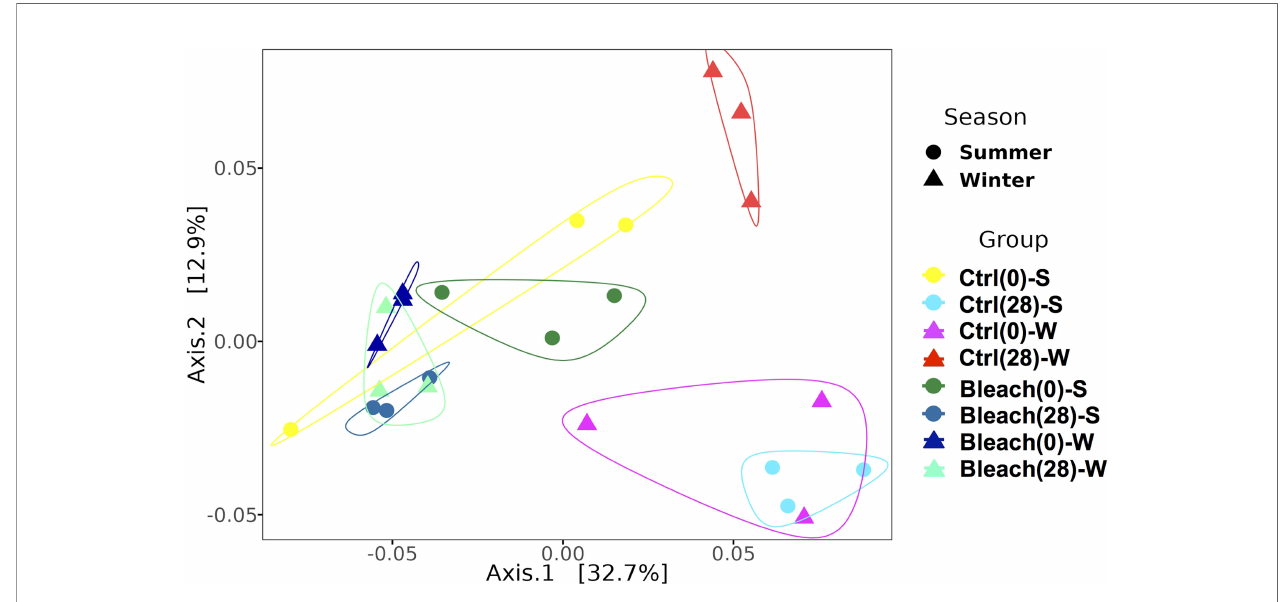
FIGURE 2 | Weighted Unifrac distance PCoA plot for SML samples. Increasing distance between points equates to decreasing similarity between samples from control (Ctrl) and bleached (Bleach) medusas at day-0 and day-28 in summer (S) and winter (W). The polygons denote groups of samples formed. Circles represent a single sample of summer and triangles represent a single sample of winter; the same color represents independent samples per condition or season. Signi fi cant differences were found for season (p = 0.017) and symbiotic condition (p = 0.001) after a PERMANOVA comparison (see Table 2 ).